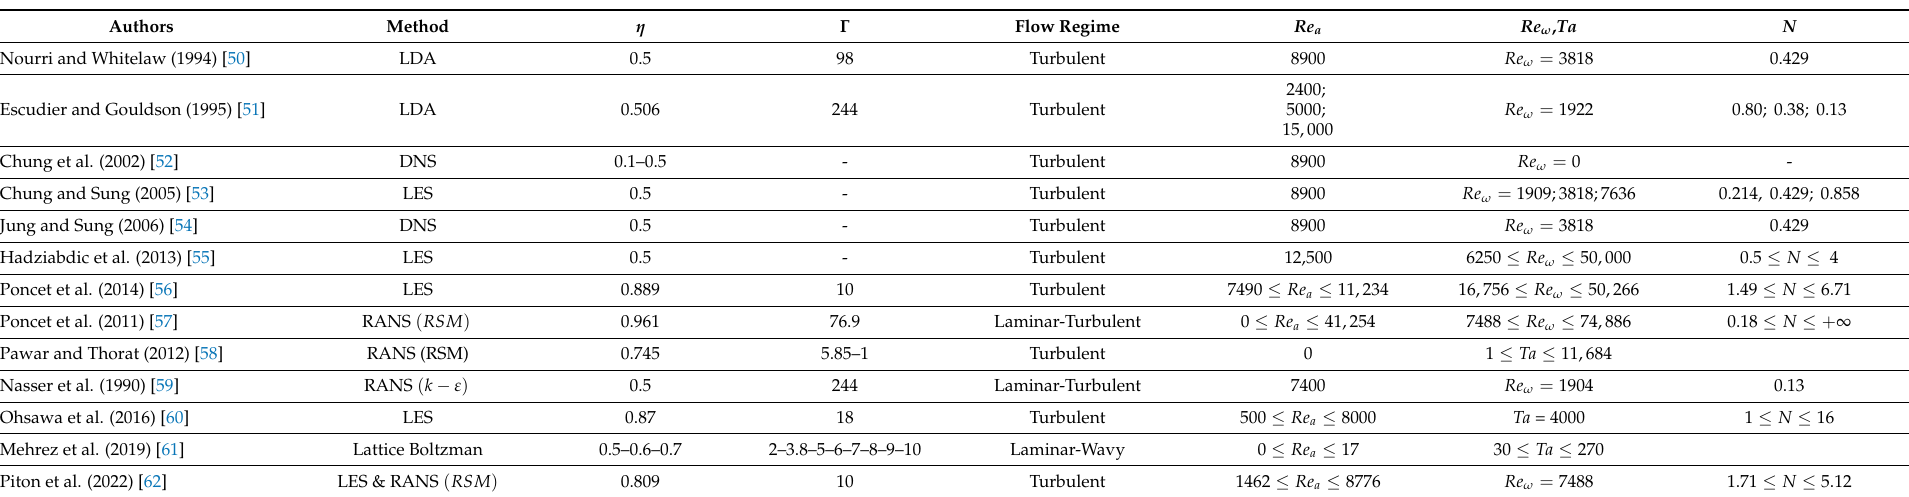
Table 2. Numerical and experimental studies in TC and TCP flows identified in the